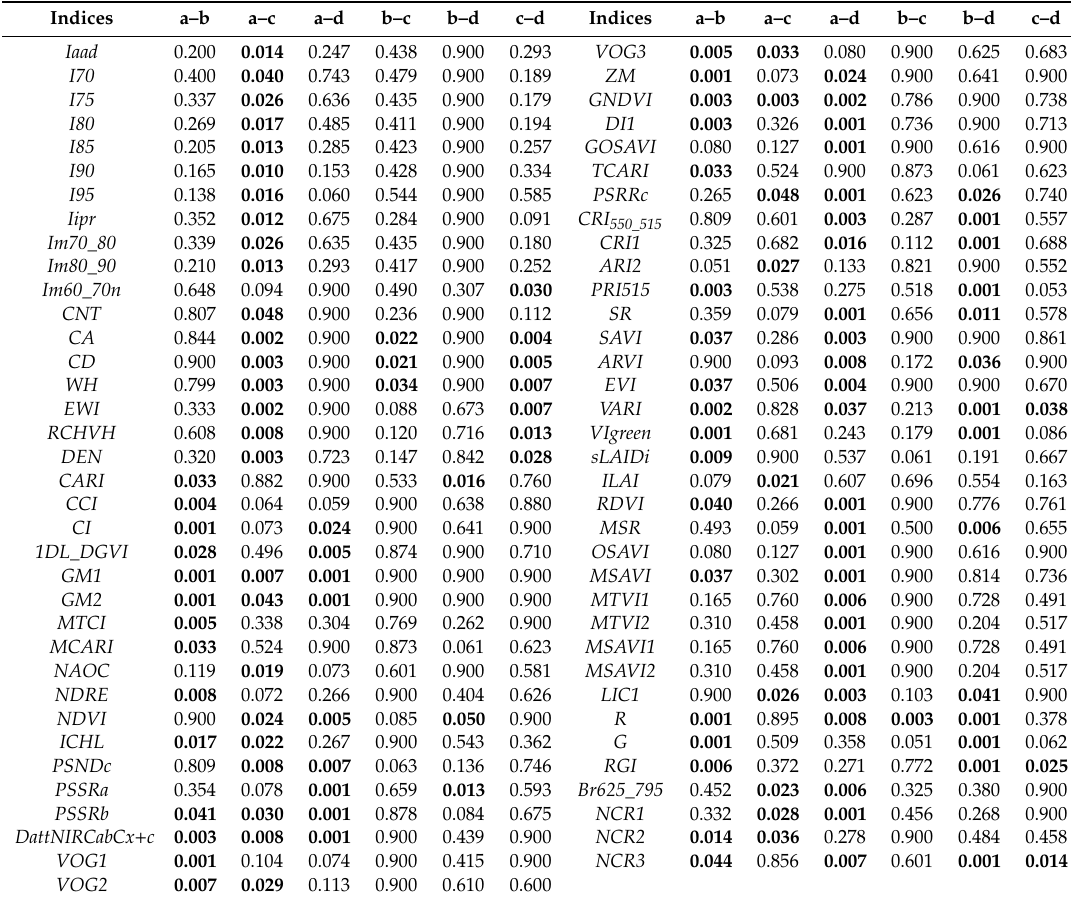
Table A3. Results of Tukey’s HSD test for the indices values between healthy trees (damage score = 0) of di ff erent tree species. a, b, c, and d referred to Acer spp., Aesculus spp., Platanus spp. and Tilia spp., respectively. The di ff erence with a significance level of p < 0.05 are marked in bold. Only the indices whose values showed significant di ff erence between at least two tree species are